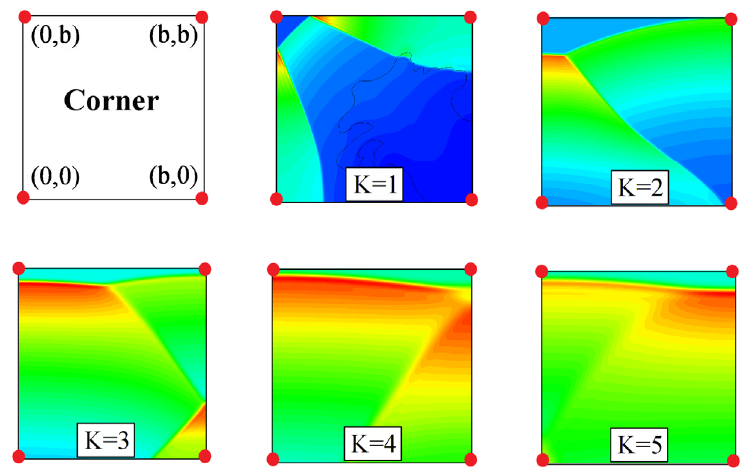
Figure 9. The cloud diagram of the convergence effect of shock waves at the corner at different K values when b = 500 mm and W = 100 g.